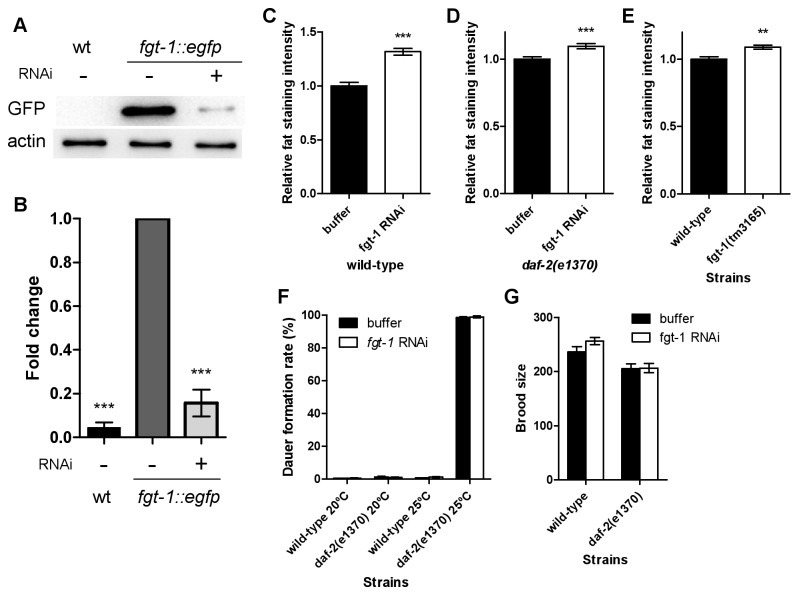
Functional analyses of fgt-1 on fat storage, dauer formation and brood size in C. elegans.A. The expression of the fgt-1::egfp fusion protein was detected by Western blot analysis using an anti-GFP antibody in the wild-type worms (wt) injected with (+) or without (-) the fgt-1 double-stranded RNA (dsRNA, RNAi). B. The intensities of the fusion protein in A were quantified by Image Lab Software and were normalized to β-actin levels. Error bars represent SEM (n = 4). C, D, and E. Fat accumulation in the fgt-1 RNAi wt (C) and daf-2(e1370) mutant worms (D), as well as in fgt-1(tm3165) mutant animals (E, no RNAi), was measured by Sudan black B staining. Staining intensity was quantitated using ImageJ software (NIH). Error bars represent SEM (n ≥ 41). Statistical analysis was conducted using Student’s t-test (**P < 0.01, ***P < 0.001). F and G. Comparison of the effects of fgt-1 knockdown on the dauer formation rate (F) and brood size (G). In F, wild-type and daf-2(e1370) worms were incubated at either 20 °C or 25 °C. Error bars represent SEM (n ≥ 9 and 25 for F and G, respectively). Statistical analysis was conducted using Student’s t-test.